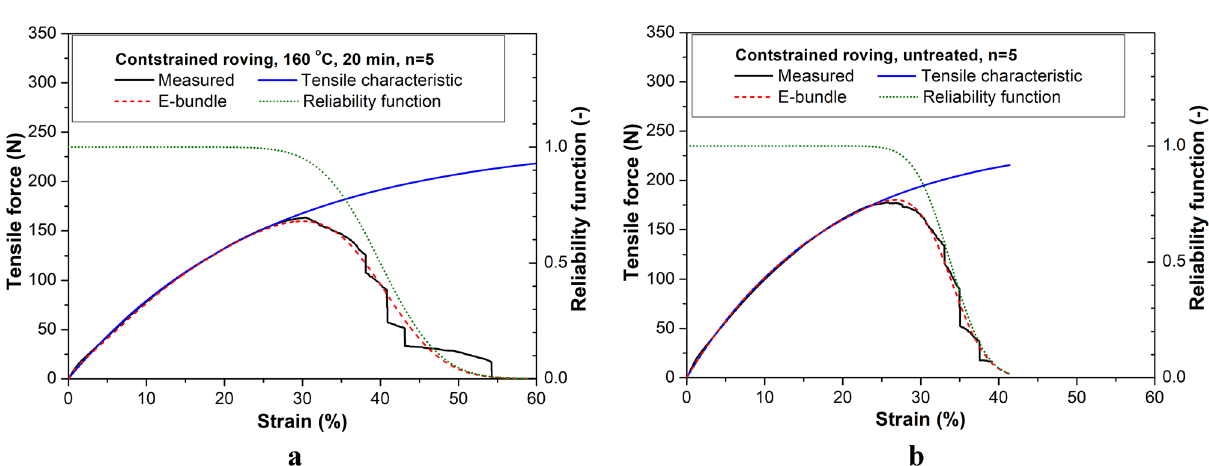
Figure 9. Measured mean tensile test curve, the fitted tensile characteristic, reliability function, and nonlinear E-bundle curve of constrained fibers ( a ) and rovings ( b ) without heat